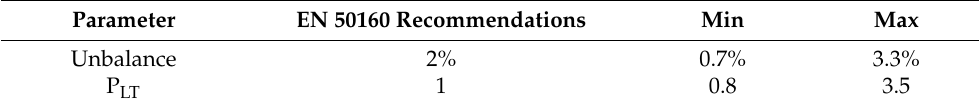
Table 2. Voltage unbalance and flicker measurement results for Object 1.